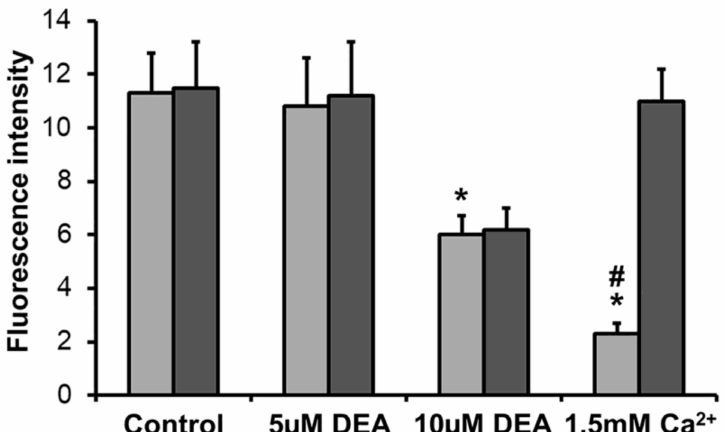
Figure 5. E ff ect of DEA on mPT in intact B16F10 melanoma cells. Cells were treated with 5 or 10 µ M of DEA or 1.5 mM of Ca 2 + (positive control [27]) in the presence (dark bars) or absence (light bars)